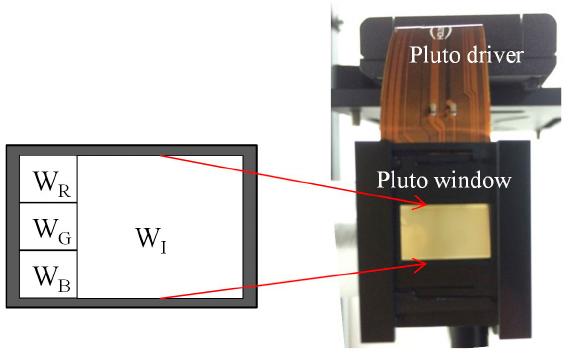
Figure 2. Sub-window partition for beam shaping and imaging DPE display.